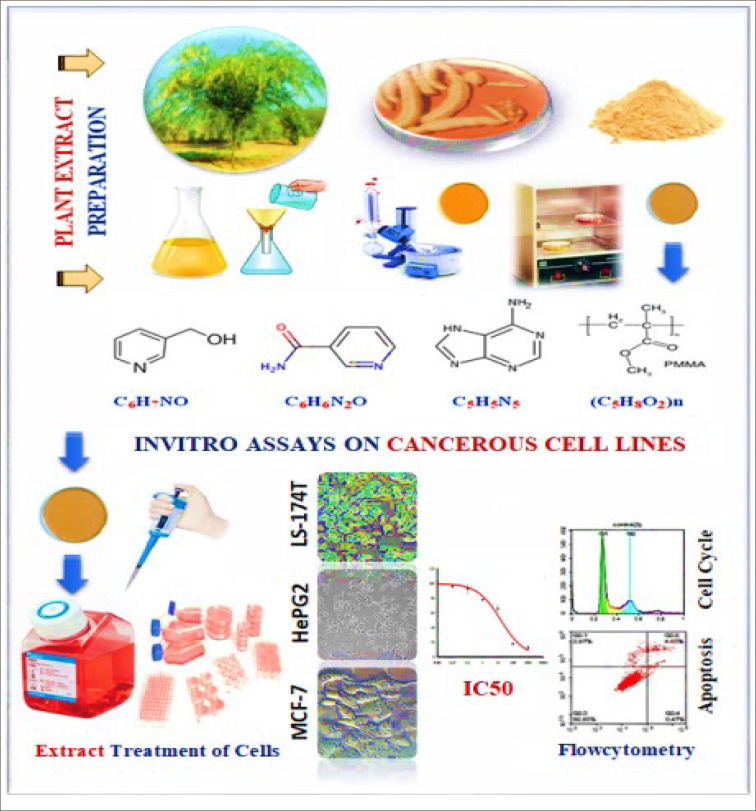
Graphical abstract